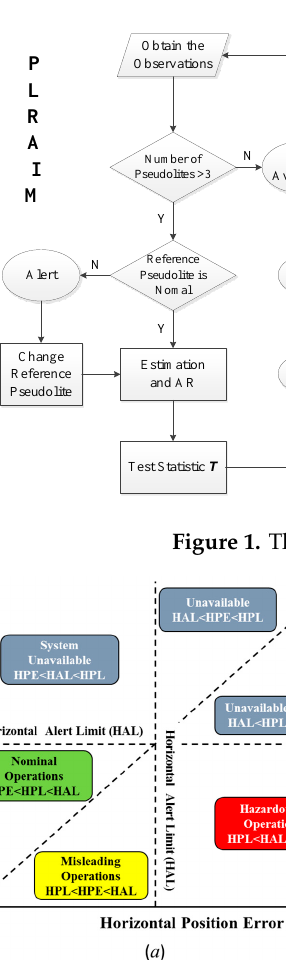
Figure 2. ( a ) Events according to the Stanford Diagram, ( b ) Sketch Map of MI and HMI.